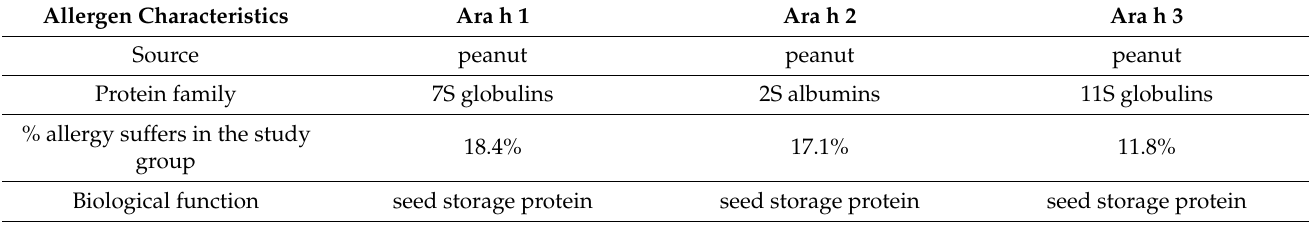
Table 5. Comparison of major peanut allergen Ara h 1, Ara 2 and Ara h 3 belonging to different protein families (https://www.uniprot.org/ (accessed on 23 December 2022)).